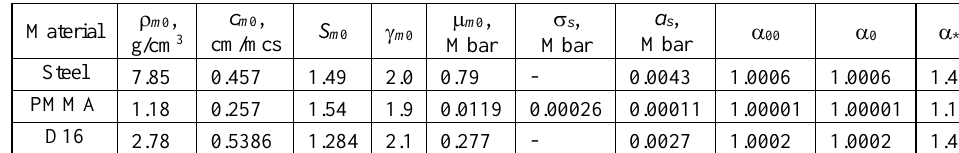
Table 1. The mathematical model parameters.